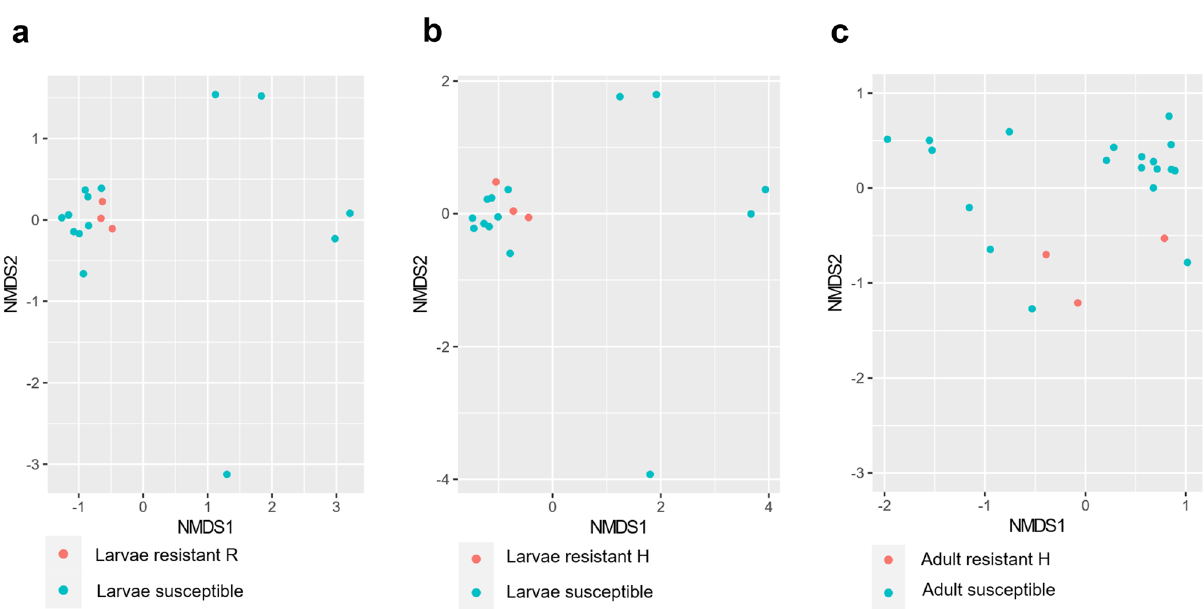
Figure 5. Gut bacterial communities of larvae and adult bee of SBV-resistant strain compared to SBV- susceptible strain were analysed by the non-metric multidimensional scaling (NMDS). The analysis was done for comparison of microbiome of SBV-resistant larvae strain R ( a ) and strain H with SBV-susceptible strain ( b ), and of adult bee of resistant strain H and susceptible strain ( c